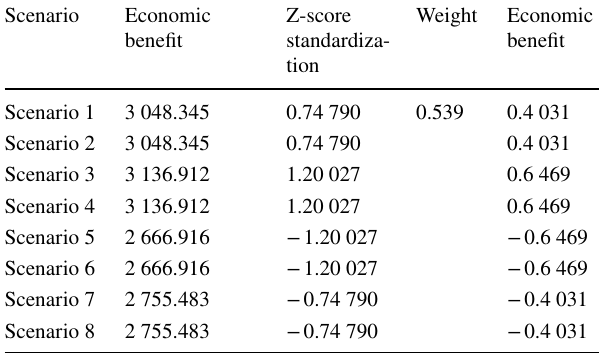
Table 3 Economic benefit value of each scenario in 2035 Scenario